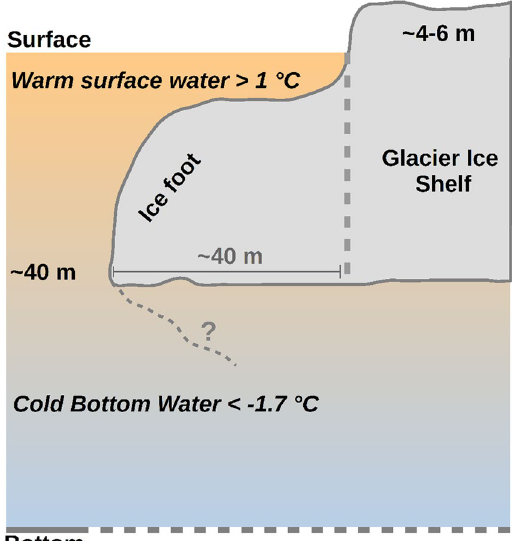
Figure 2. Ice foot at the terminus. Conceptual illustration of the terminus at the NW-outlet ice shelf from Flade Isblink ice cap showing an ice foot of about 40 m deep and a height of 4–6 m above sea level (observed ice foot shapes are shown in Fig. 5e). The vertical dashed line show the terminus after calving of the ice foot. The question mark below the ice foot indicate the unknown shape (dashed line) below the glacier.